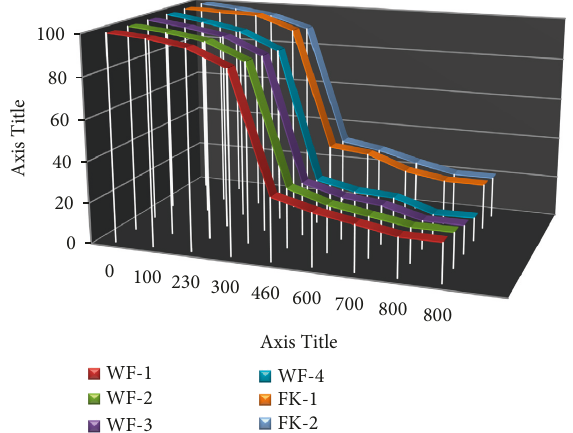
Figure 10: TGA of newly developed composites with variation wheat straw-PAN and kevlar in N 2 atmosphere.